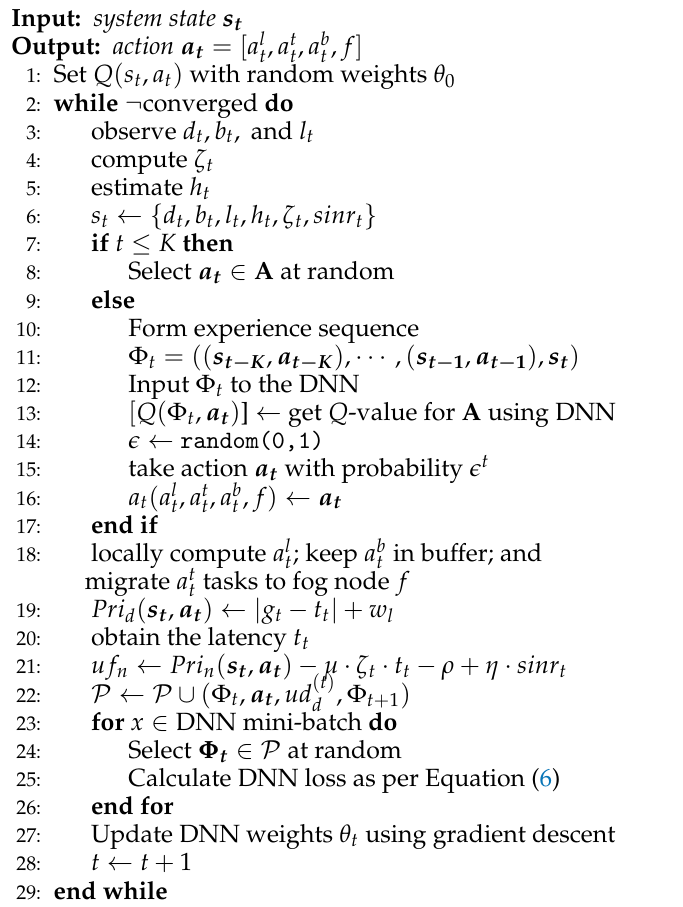
Algorithm 1 Device Module